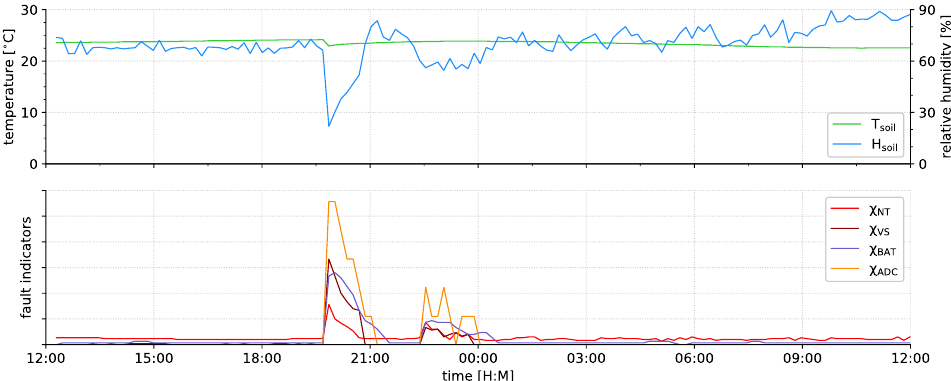
Figure 16. Faulty sensor reading successfully reported by the fault indicators.